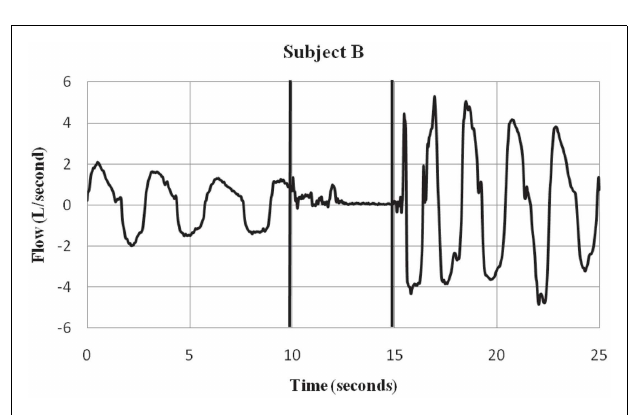
FIGURE 1 | SubjectA – respiratory flow pre, during and post-ECD exposure. SubjectA is an example of a participant who showed both inspiratory and expiratory activity during the ECD exposure period. Only a few of the subjects showed this pattern of respiratory activity during ECD exposure.The vertical lines indicate the onset and offset of ECD exposure. Negative values represent inspiratory flow .